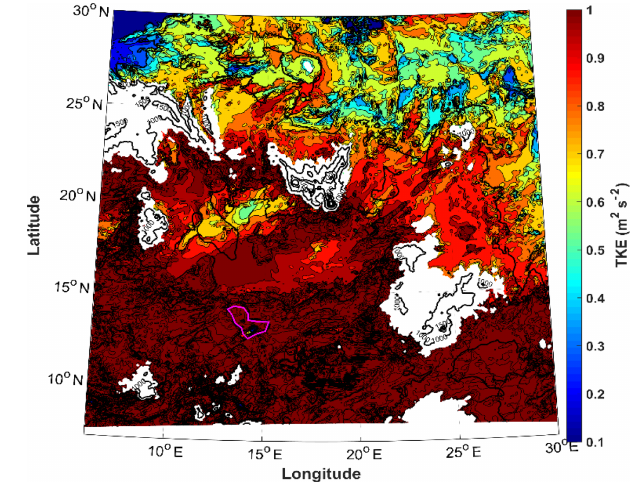
Figure 12. Turbulent kinetic energy at 925hPa on 12:00UTC 8 De- cember 2011 (6km resolution WRF